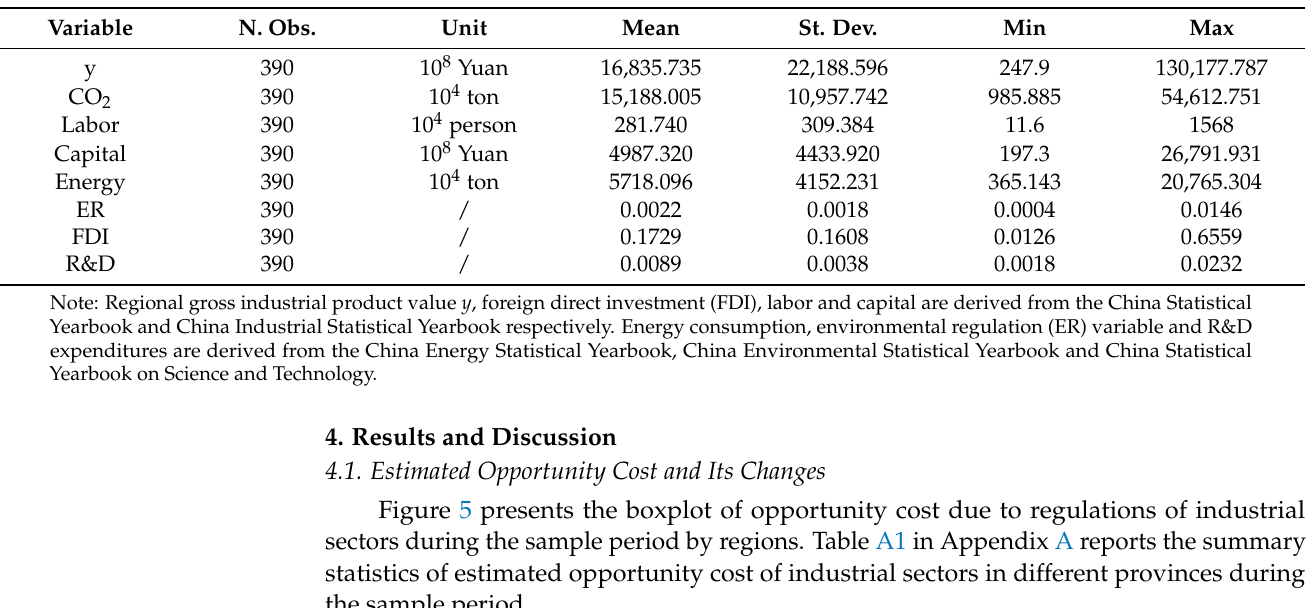
Table 1. Summary statistics